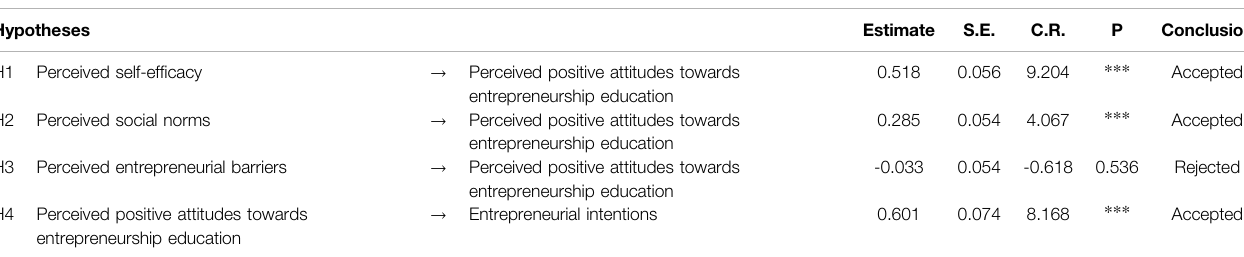
TABLE 6 | Theoretical framework testing.